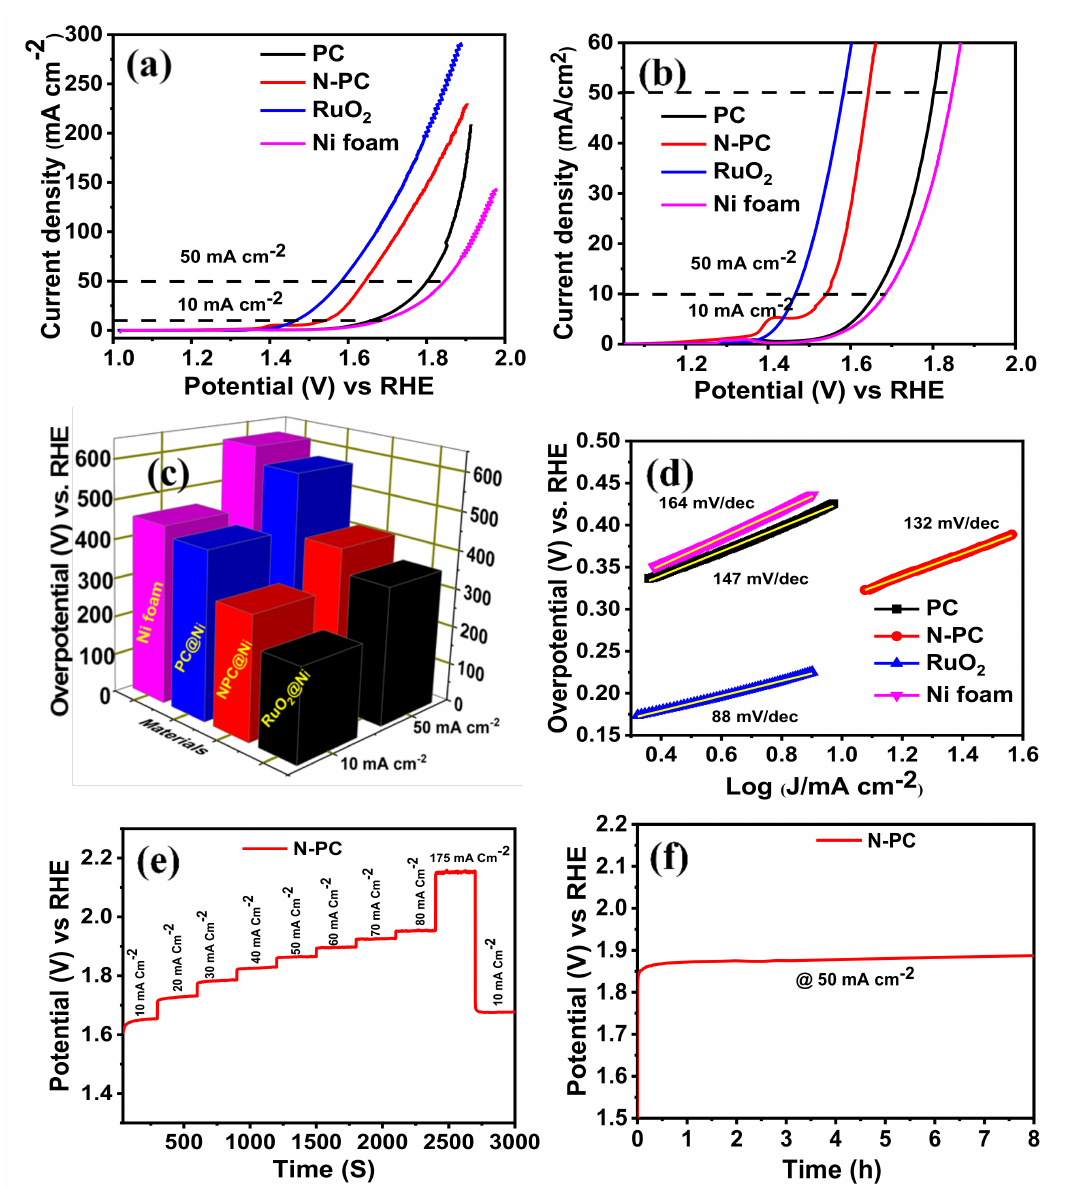
Figure 8. ( a , b ) Oxygen evolution reaction (OER)-LSV curves of PC@Ni, N-PC@Ni, RuO 2 @Ni and Ni foam in 1 M KOH at a scan rate 1 mV s − 1 [with iR-correction]; ( c ) bar of prepared catalyst vs overpotential at 10 and 50 mA cm − 2 ; ( d ) Tafel slopes of PC@Ni, N-PC@Ni, RuO 2 @Ni and Ni foam; ( e ) multiple-step chronopotentiometric of N-PC@Ni; ( f ) chronopotentiometric curve of N-PC@Ni at a constant of 50 mA cm −